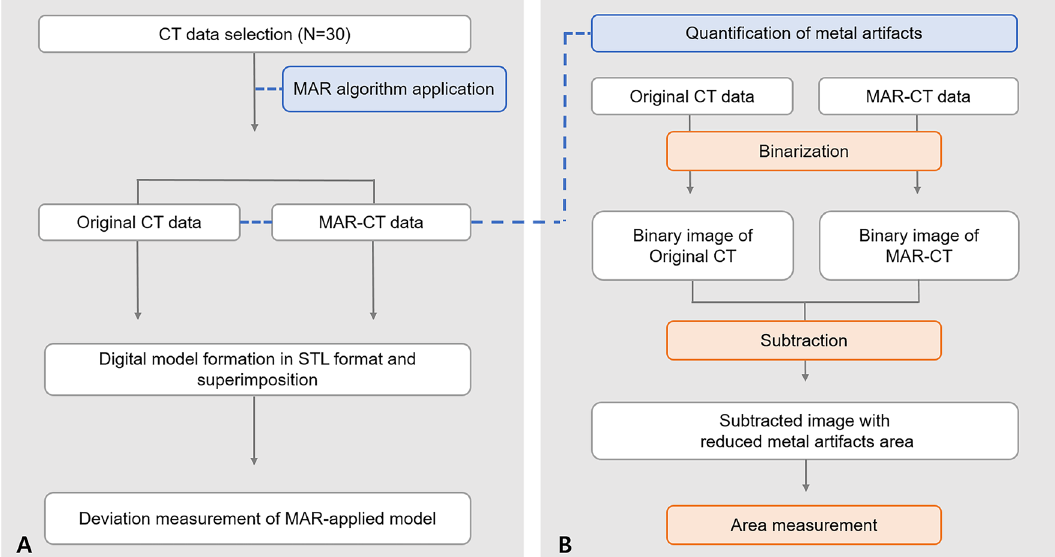
Figure 1. Schematic workflow of ( A ) the overall study procedure and ( B ) the metal artifact quantification procedure. MAR metal artifact reduction; STL standard tessellation